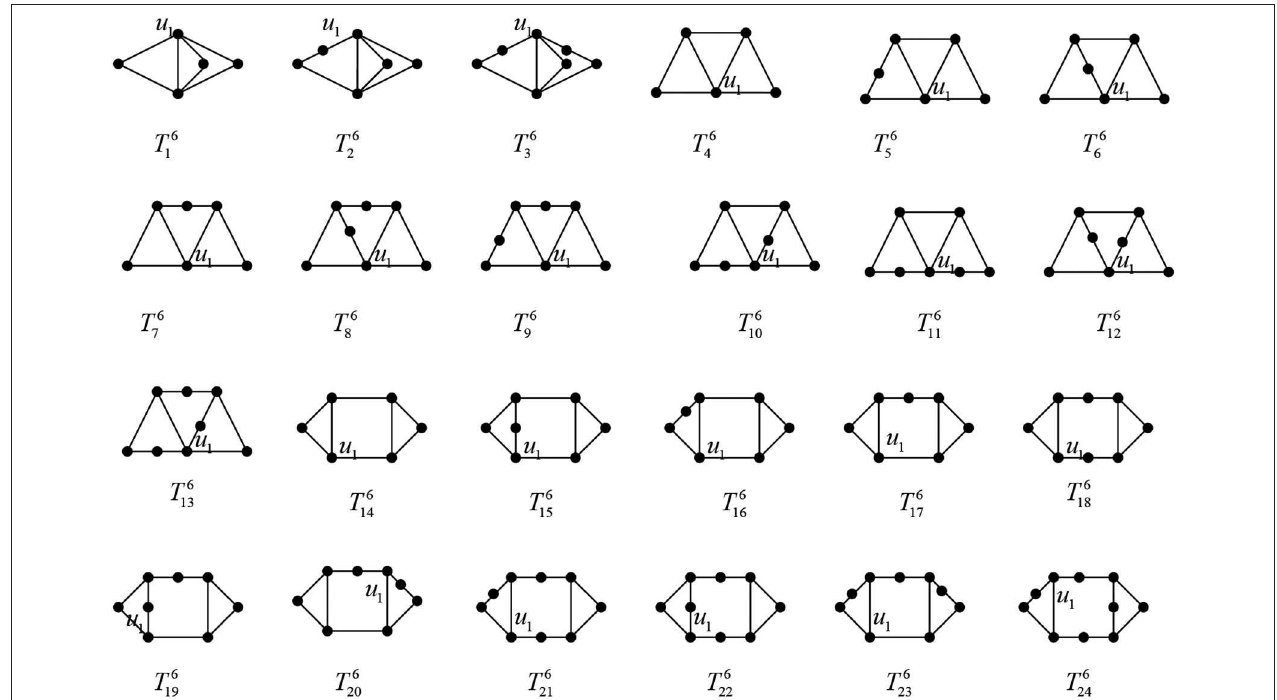
FIGURE 9 | The graphs T 6 i ( i